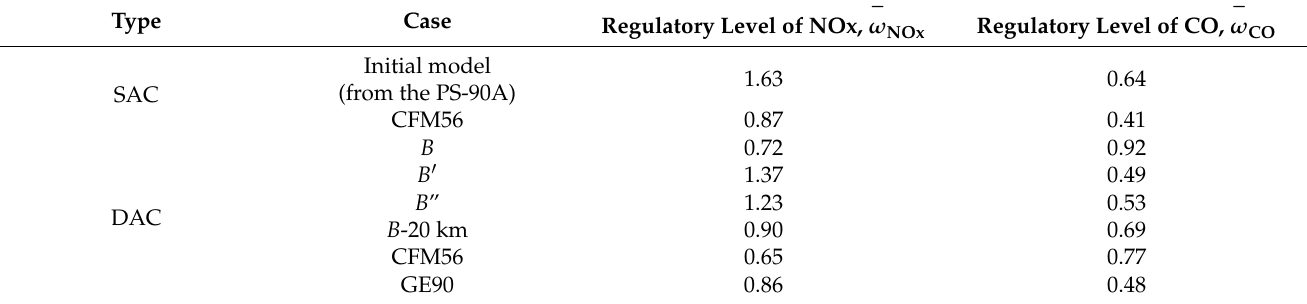
Table 9. SAC and DAC emissions with calculated values and real data from ICAO.